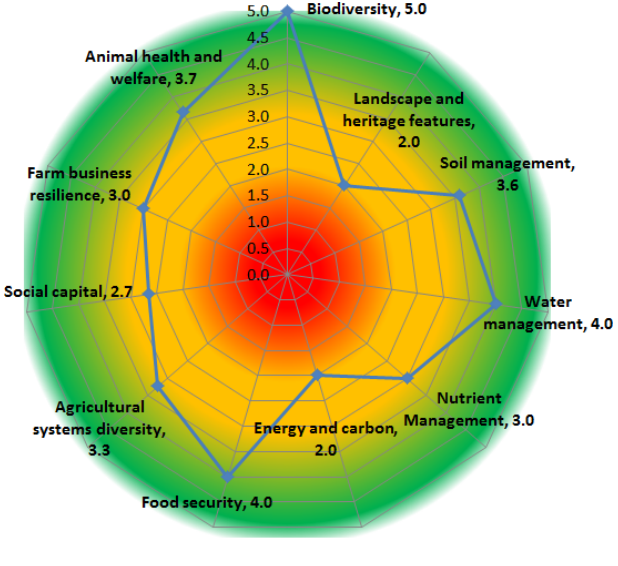
Fig. 2 . Radar diagram showing an example from the pilot assessment (Gerrard et al.